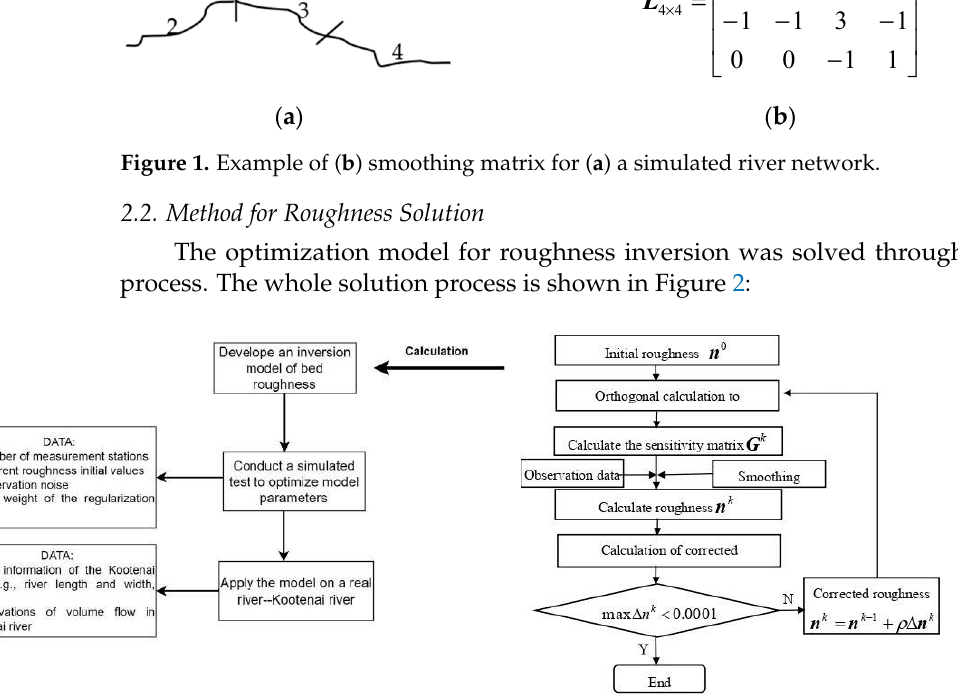
Figure 2. Workflow diagram.